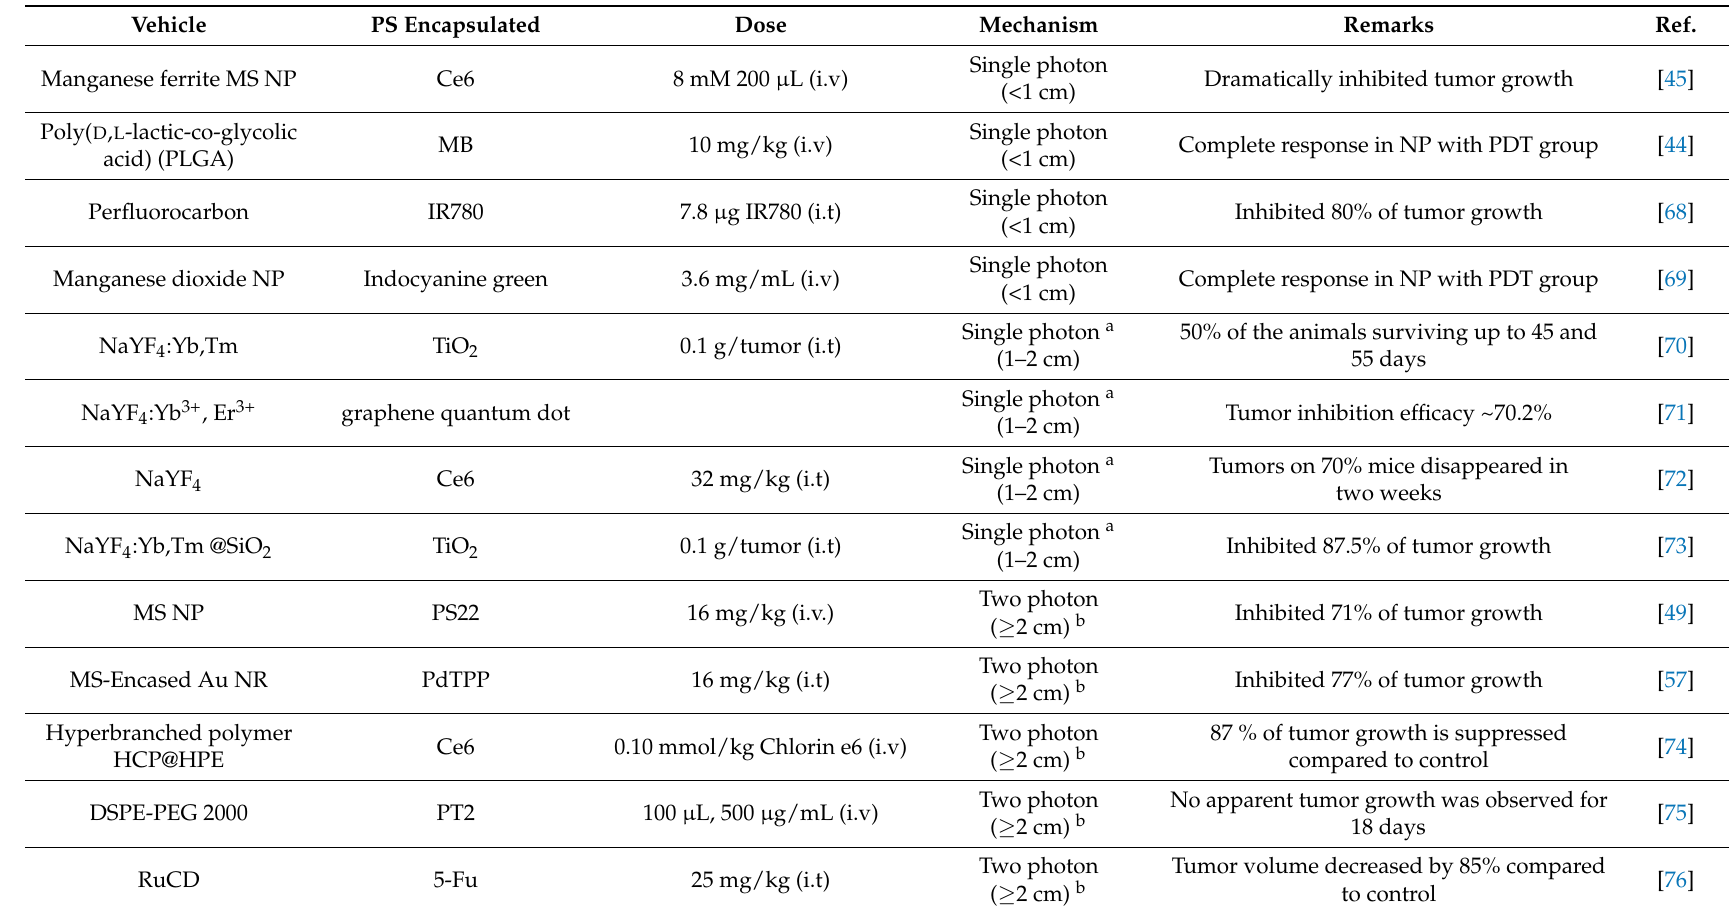
Table 1. Nanoparticle (NP) formulations for photosensitizer